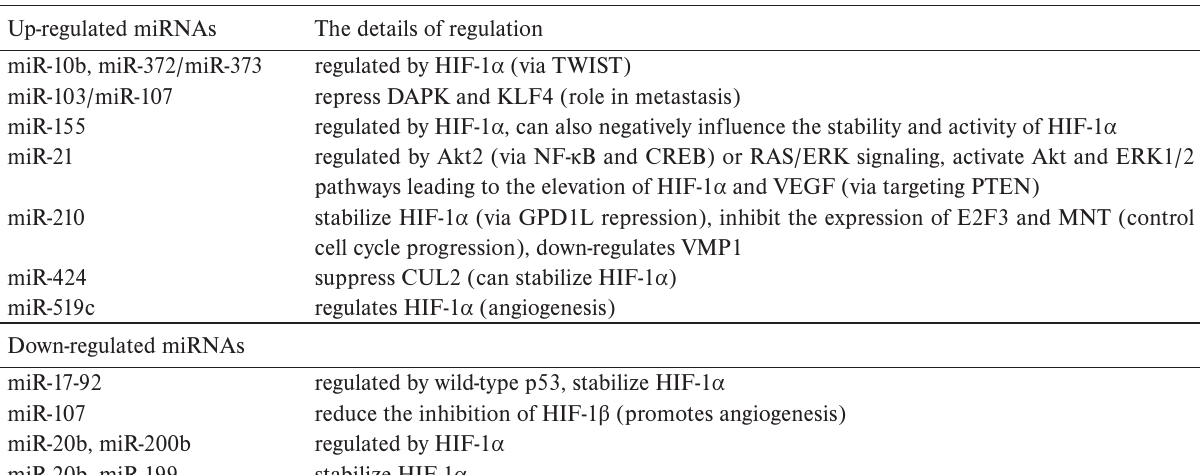
Table 2. Examples of changes of miRNAs expression in response to hypoxia (adapted according to ref. 54 ). mRNAs can be up- regulated as well as down-regulated, which reflects the complexity of miRNA in hypoxia regulation. Up-regulated miRNAs The details of